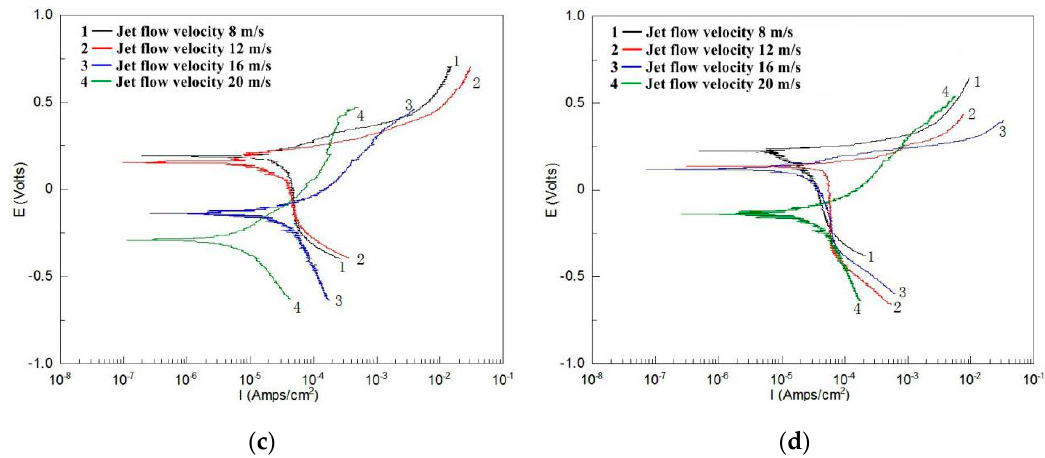
Figure 6. Polarization curves of 13Cr within an angle of 30° up to 90° (2 wt % NaCl + distilled water).